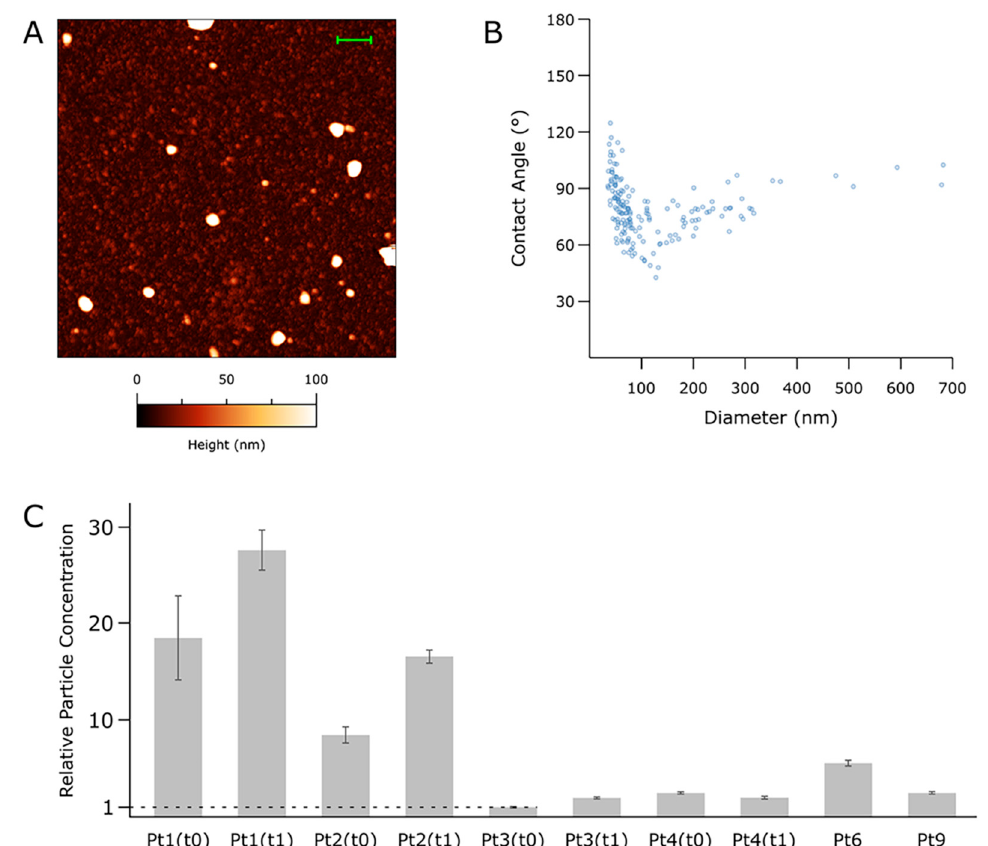
Figure 1. Atomic Force Microscopy (AFM)-based, single-particle nanomechanical analysis of putative vesicles found in 10 representative samples from the panel. ( A ) Representative AFM micrograph from one of the samples (Pt 6, scalebar = 1 µ m). At least five such images were recorded for each sample; representative images from all the samples can be found in Figure S2. ( B ) Contact Angle (CA) vs. Diameter (D) plot for the sample shown in panel ( A ) (Pt 6). Each point represents one particle as measured in the AFM micrographs; the scatterplots resulting from each sample can be found in Figure S2. ( C ) Relative total particle concentrations as estimated via surface densities measured on multiple samples following the same deposition protocol. The vertical scale is given as multiples of the lowest concentration (Pt3, t0). Error bars are the standard deviation of densities from at least five different areas measured on the sample.